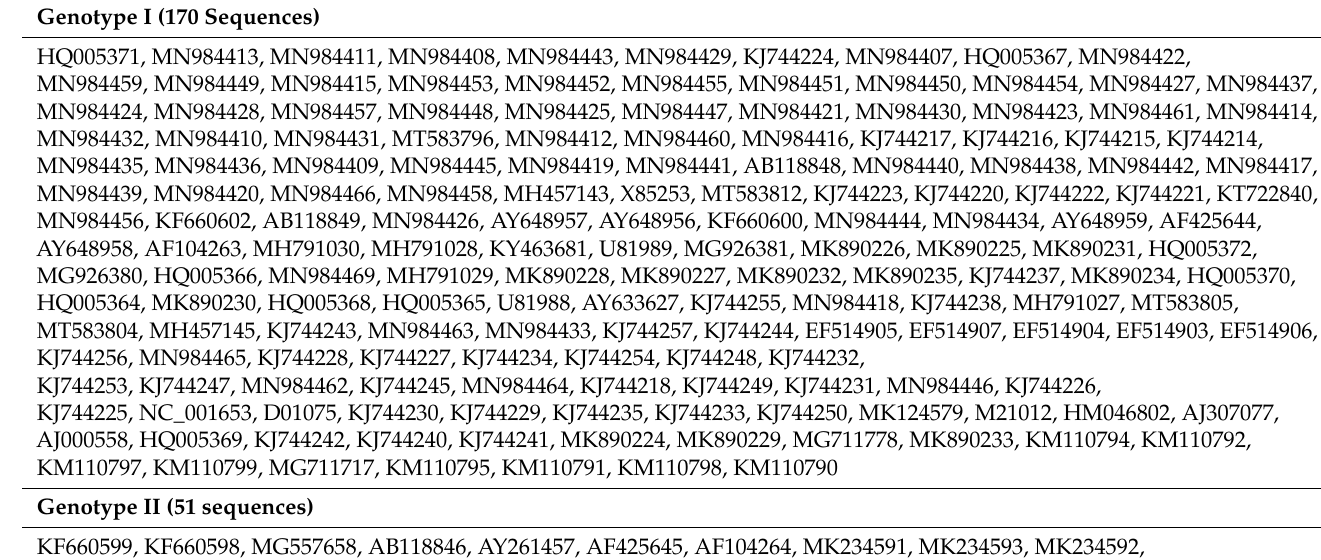
Table 1. List of GenBank IDs for HDV used in this